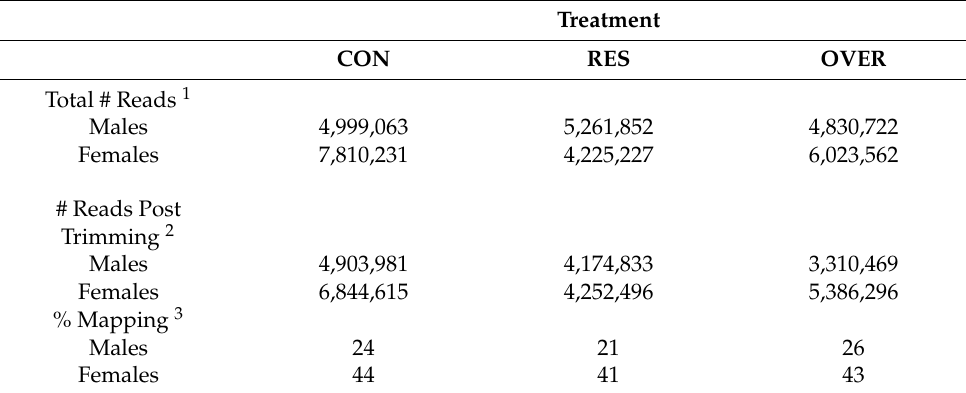
Table 1. RRBS Sequencing Information